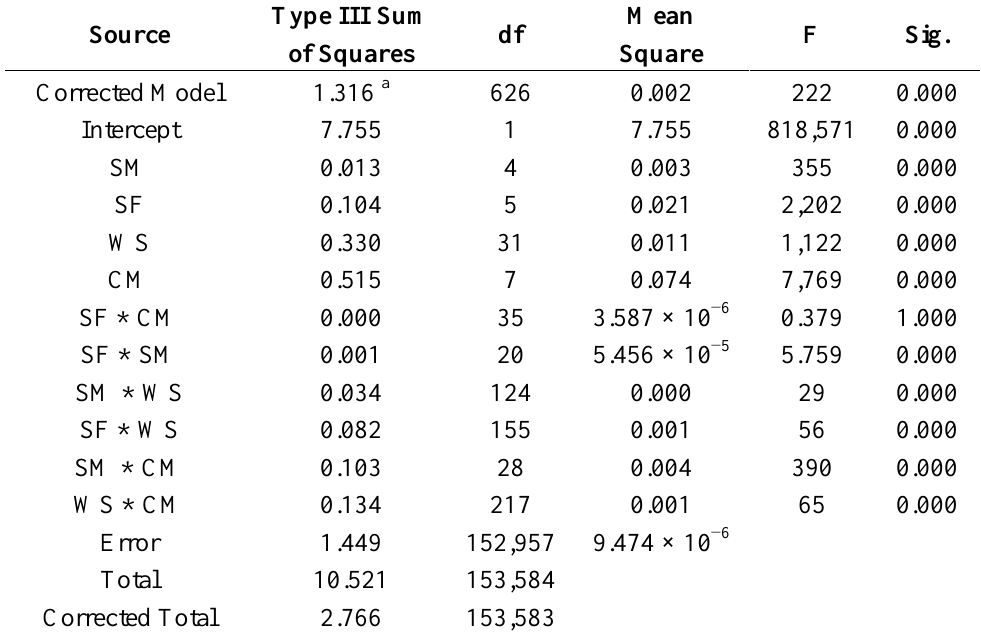
Table 4. ANOVA output for the CL as the dependent variable ( Tests of Between-Subjects Effects. Dependent Variable: CL ).